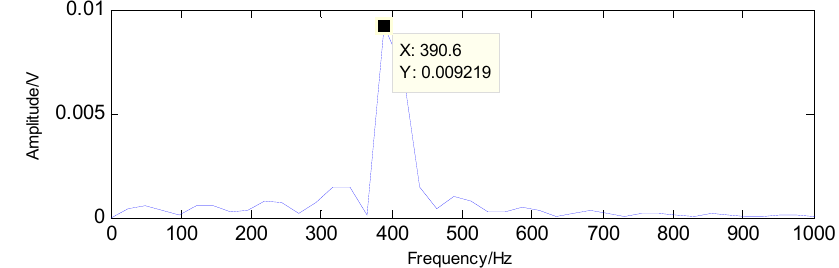
Figure 30. Random sampling of transient impact component through Gaussian random matrix.